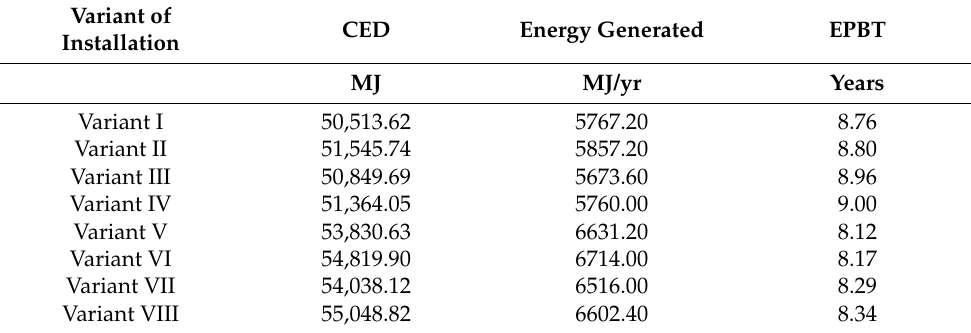
Table 3. Results of energetic and economic